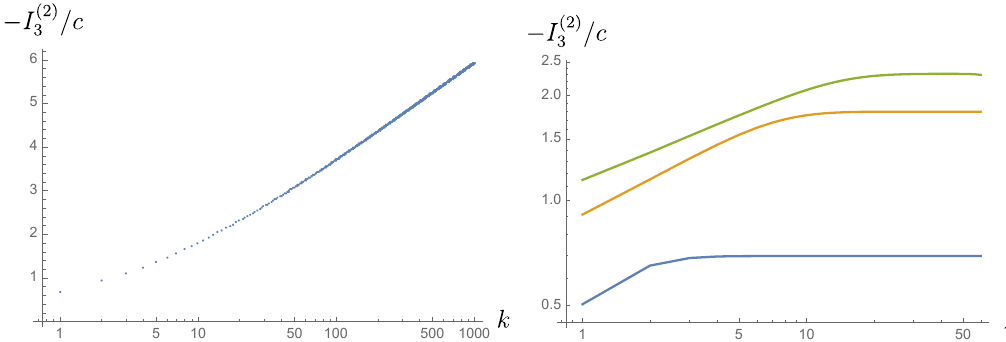
L A =(cid:15) , (cid:24)